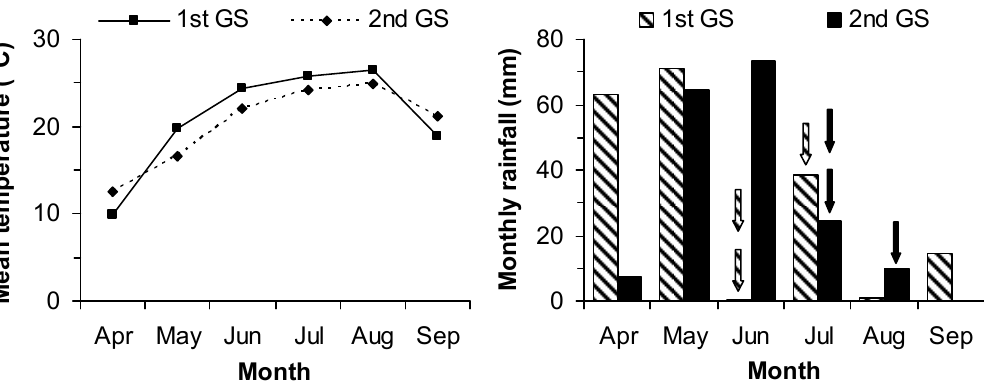
Figure 1. Mean monthly air temperature and cumulative monthly rainfall during each growing season (GS) of experimentation (arrows denote irrigation events in each GS).